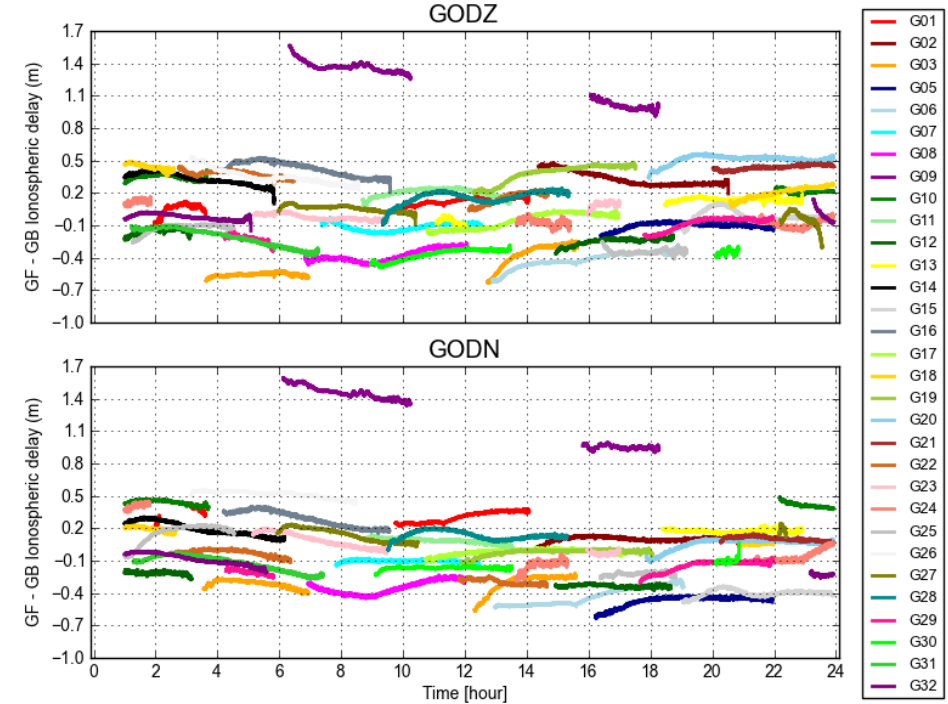
Figure 6. Differences of GF filtered and GB ionospheric delays for all of the observed satellites computed from the receiver GODZ (top) and GODN (bottom) observations using real-time OC products.